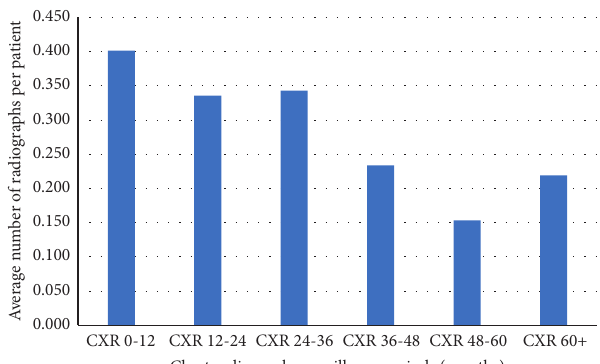
Figure 1: Histogram demonstrating the distribution of chest ra- diograph follow-up averaged per patient. The average imaging follow-up of patients undergoing chest radiograph follow-up was 50months.